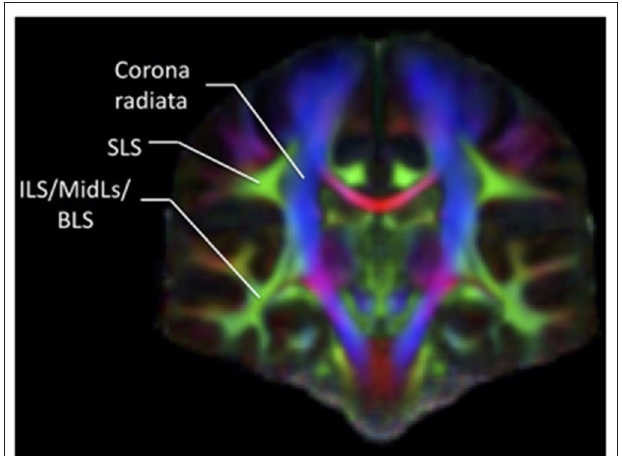
FIGURE 5 | Coronal section of a color-coded FA map. The green associative fibers, representing the fibers perpendicular to the plane, can be grouped into two main systems according to the classification by Mandonnet et al. ( 5), the SLS and the common stem for the ILS/MidLs and BLS.